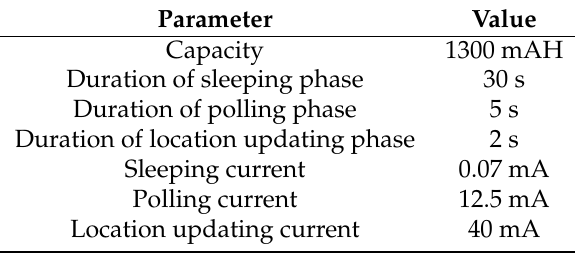
Table 2. Summary of battery and node properties